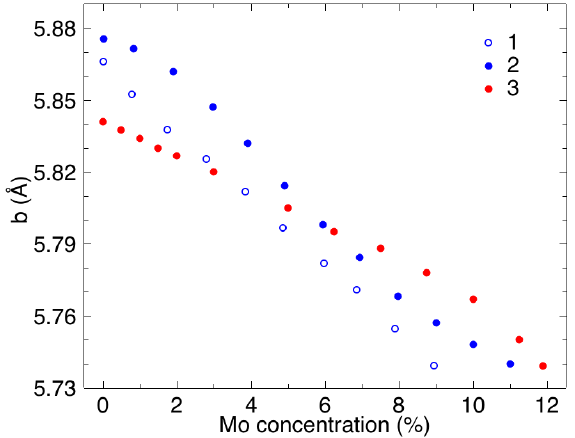
Figure 2. The lattice parameter b of α (cid:48) -phase and α (cid:48)(cid:48) -phase at room temperature (for various Mo concentrations): 1—values measured in work [14]; 2—values measured in work [19]; 3—calculated data from this